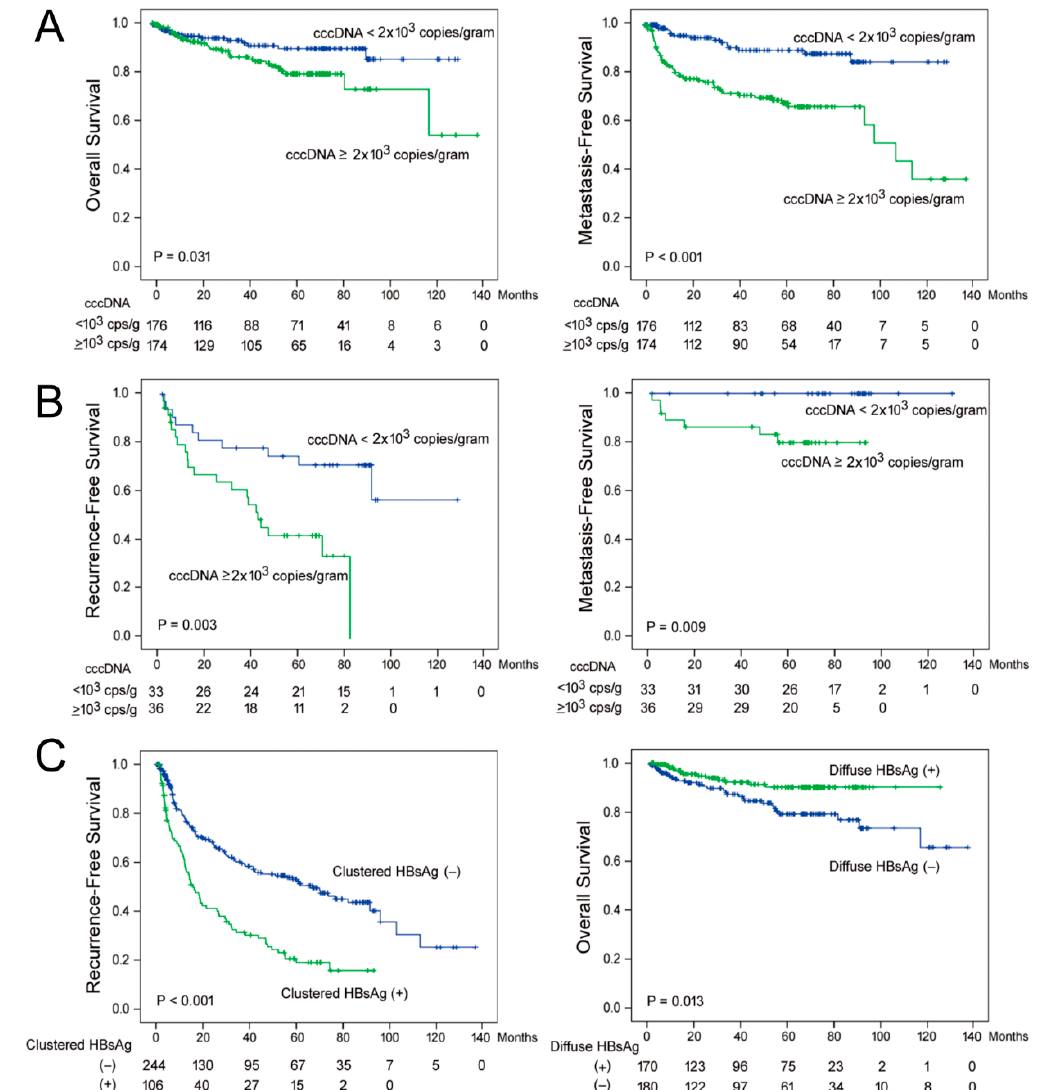
Figure 4. The association between postoperative outcomes and cccDNA levels. ( A , B ) Postoperative outcome comparisons between patients with low (blue curve) and high (green curve) cccDNA levels for all 350 patients ( A ) and 69 patients with undetectable serum HBV-DNA ( B ), respectively. ( C ) Postoperative outcome comparisons between patients with different tissue distribution patterns of HBsAg. The Kaplan-Meier analysis was conducted for all the comparisons.